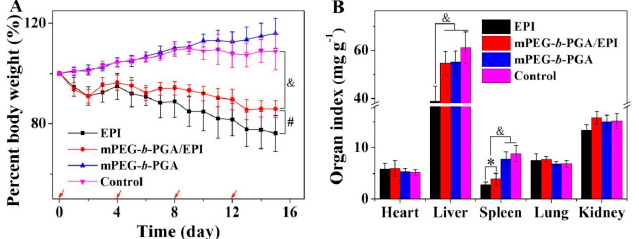
( A ) meant the treatment times. Data were presented as mean ˘ SD ( n = 10; * p < 0.05, # p < 0.01, & p <